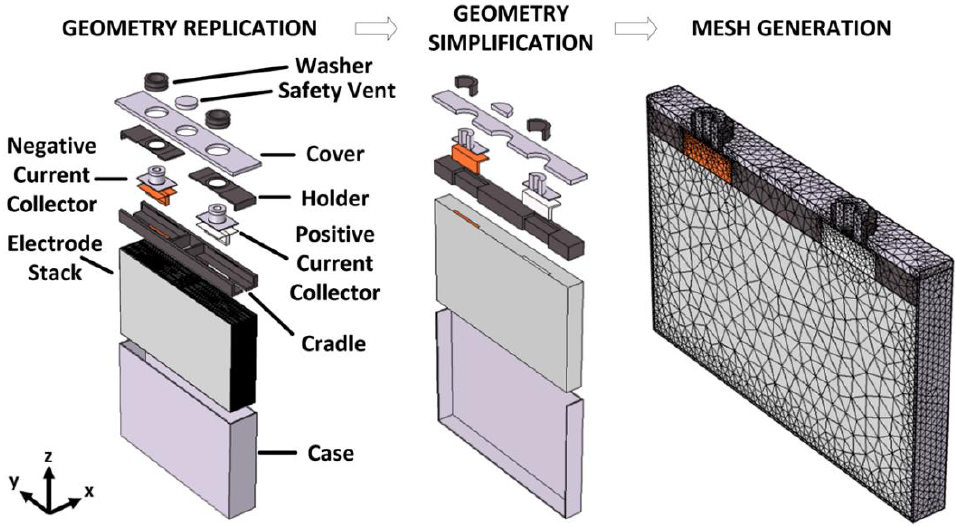
Figure 2. Virtual battery design replication process in three steps.